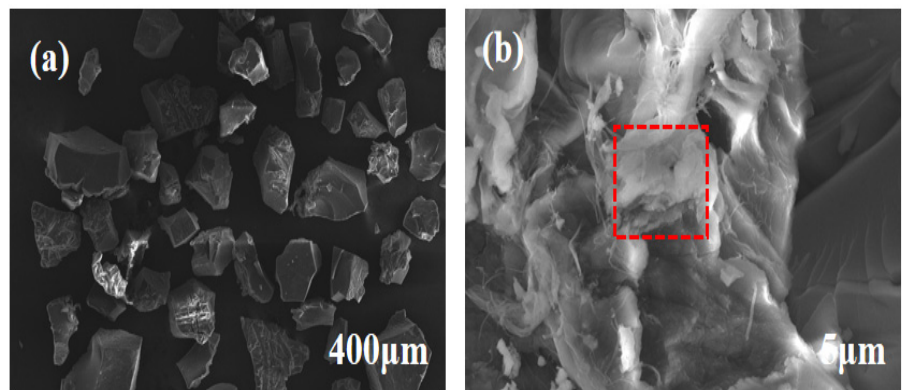
9 of 14 Figure 7. FE − SEM micrograph of tannins ( a , b ). Figure 8. HR − TEM images of tannins ( a , b ).